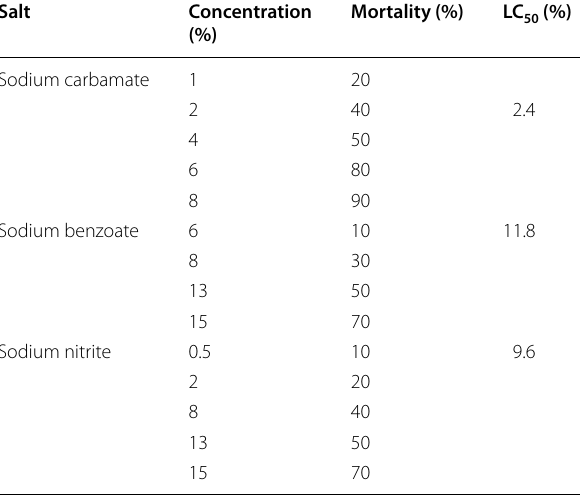
Table 1 Effect of three inorganic salts against land snail, Massylaea vermiculata, after seven days of